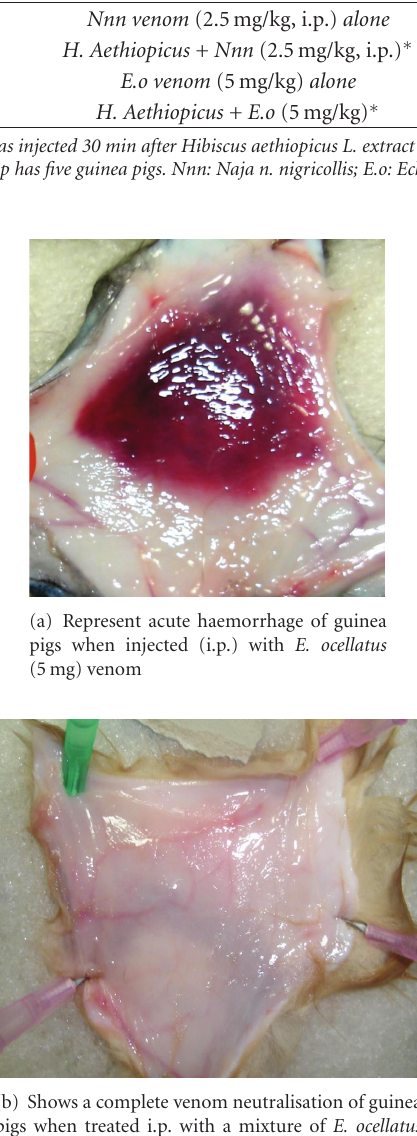
Figure 2: Administration of both venom and extract after 30 minutes pre